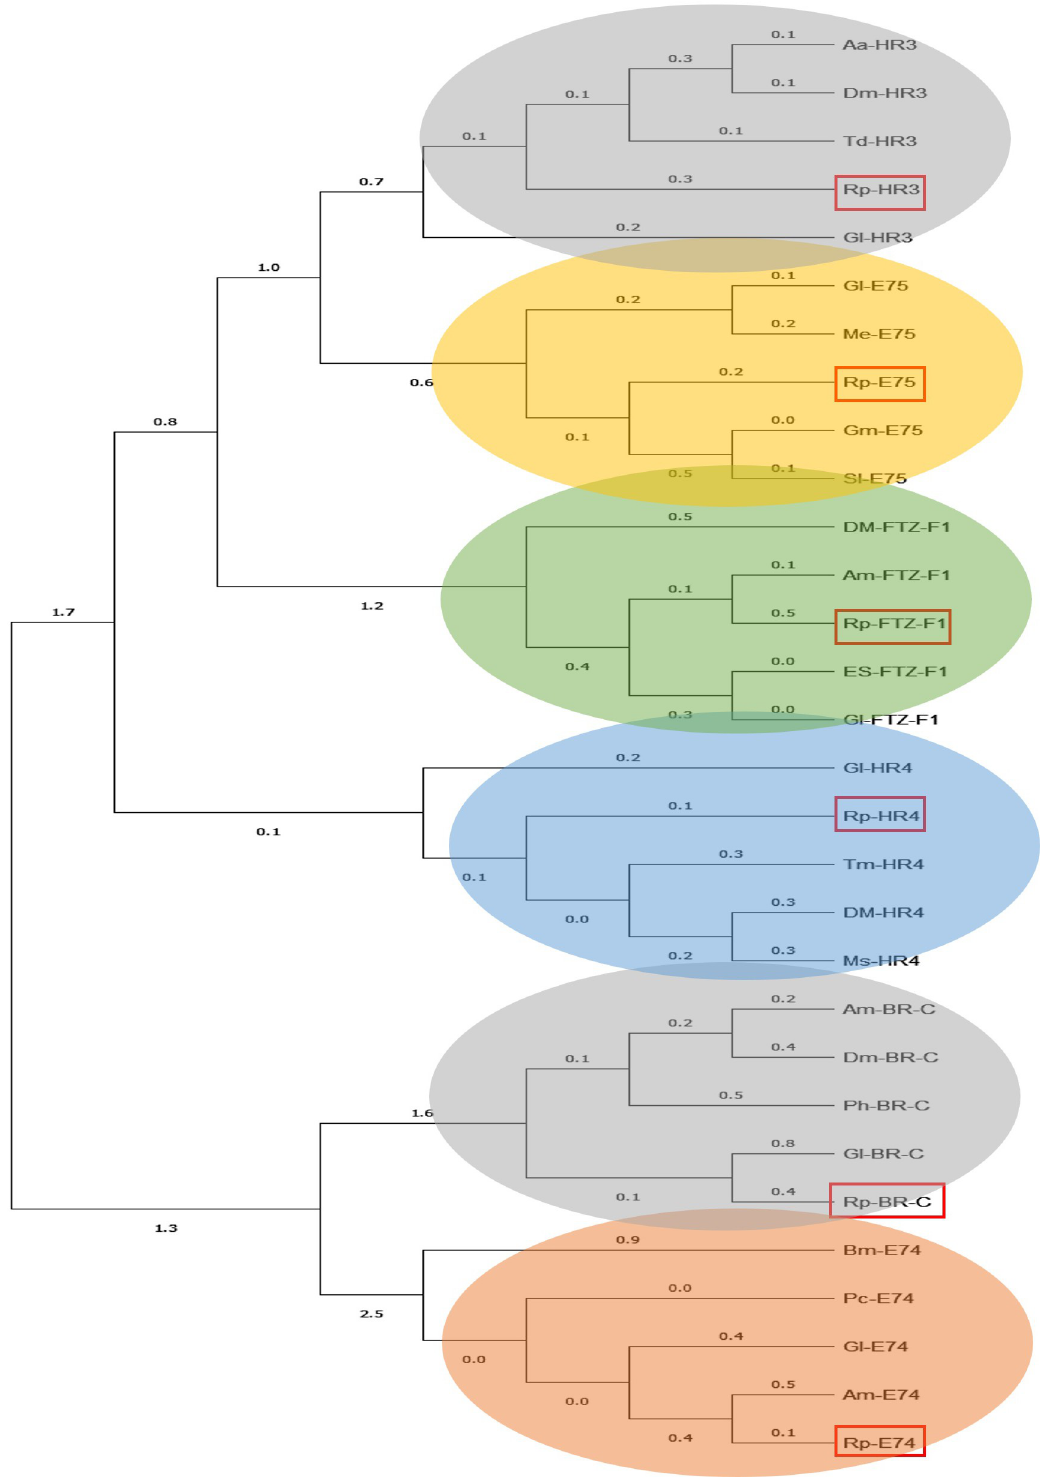
Fig 1. Phylogenetic trees showing the relationship between protein sequences of ecdysone-response genes of R . prolixus and other arthropod species. Abbreviations: Aa ( Aedes aegypti ), Dm ( Drosophila melanogaster ), Td ( Thermobia domestica ), Gl ( Gecarcinus lateralis ), Me, ( Metapenaeus ensis ), Gm ( Galleria mellonella ), Sl ( Spodoptera littoralis ), Am ( Apis mellifera ), Es ( Eriocheir sinensis ), Tm ( Tenebrio molitor) , Bm ( Bombyx mori ), Pc ( Phaedon cochleariae ), Pc ( Psacothea hilaris ).